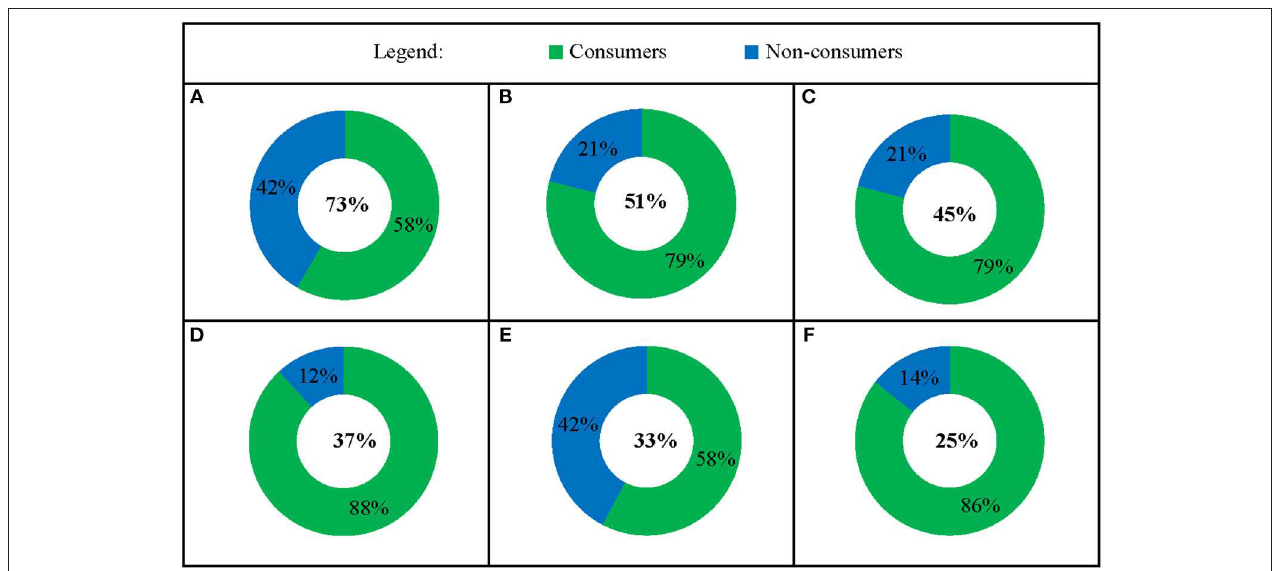
FIGURE 11 | Consumer knowledge and perceptions of lentils. Percentage of all informants (center) and proportion of lentil consumers and non-consumers that reported they (A) find the taste of lentils desirable ( p = 0.0028), (B) feel knowledgeable regarding the nutritional benefits of lentils ( p < 0.0001), (C) feel knowledgeable regarding how to cook with lentils ( p < 0.0001), (D) feel knowledgeable regarding how to include lentils in their diet in a nutritionally balanced way ( p < 0.0001), (E) agree that lentils are classified as both a protein and a vegetable in the 2015 Dietary Guidelines for Americans, and (F) they feel knowledgeable regarding how to use different lentils in a variety of dishes ( p < 0.0001) ( n = 138).